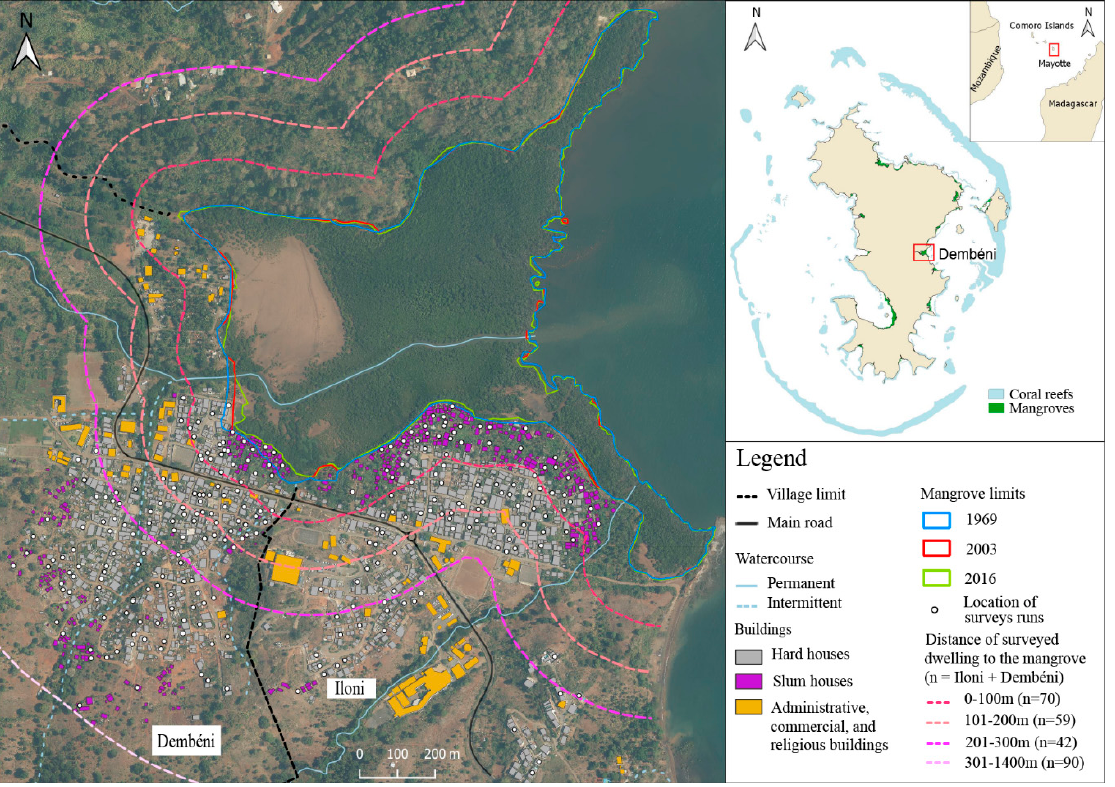
Figure 1. Map of the surface evolution of the Dembéni mangrove and the villages of Iloni and Dembéni. Sources: aerial photographs: IGN 2016; cartographic data: BD topo ® IGN ; mangrove limits: [40].